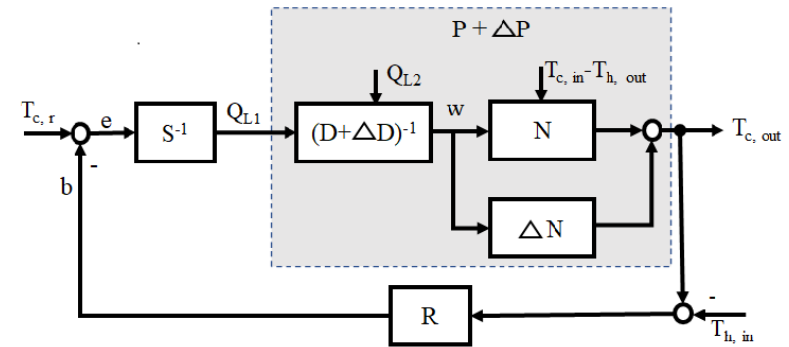
Figure 6. Operator-based fractional order robust control.